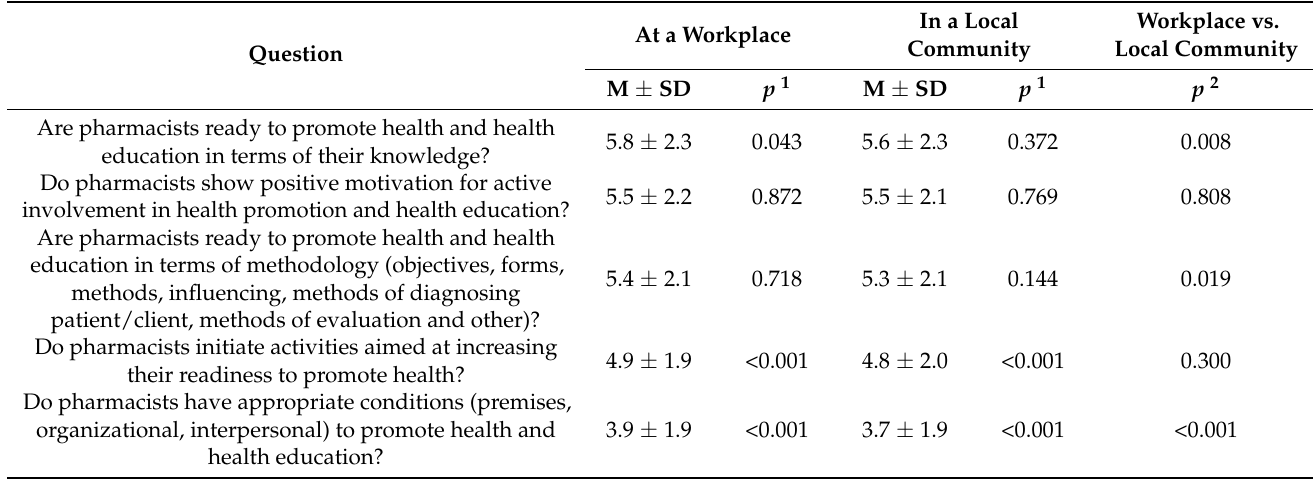
In a Local Workplace vs. Community Local Community